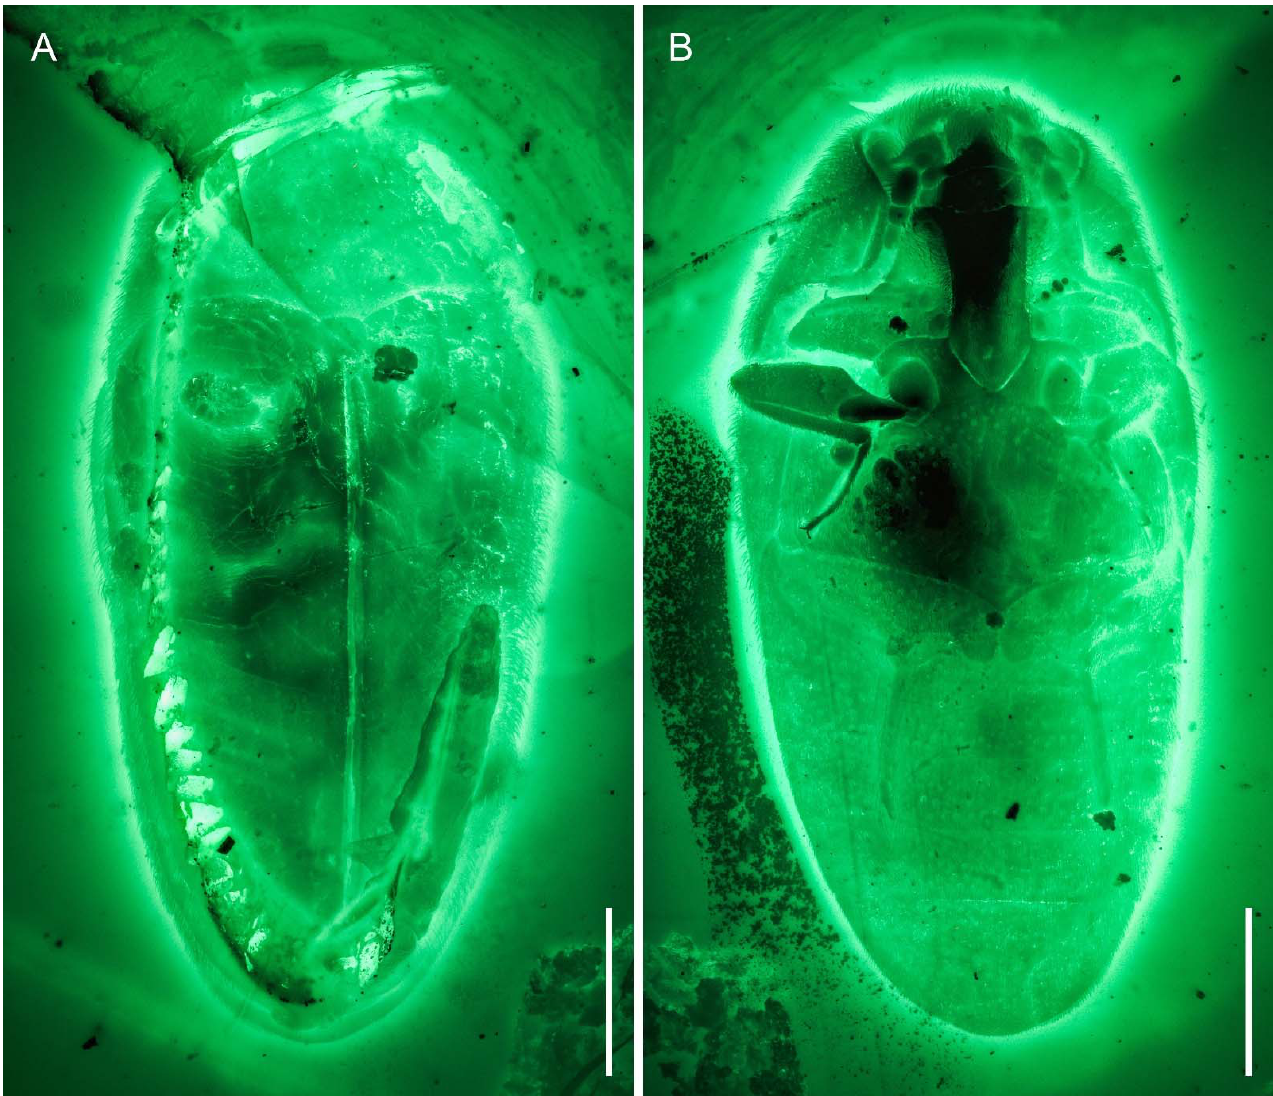
Figure 8. General habitus of Pseudopactopus robustus gen. et sp. nov. , holotype, NIGP173917, under widefield fluorescence. ( A ) Dorsal view. ( B ) Ventral view. Scale bars: 500 μ m.